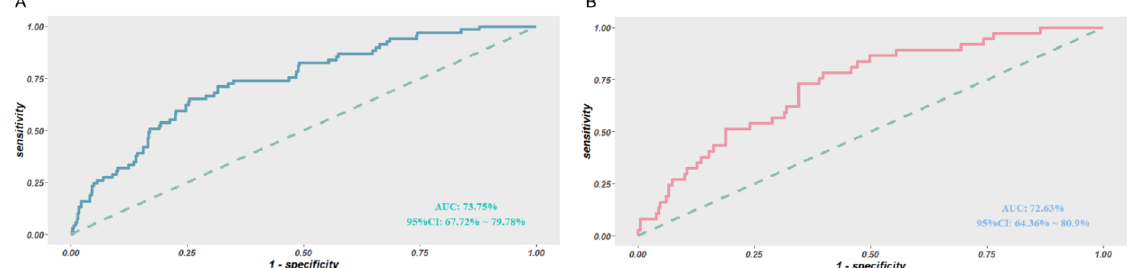
Figure 4. ROC curves of the MCI risk nomogram prediction in the training set ( A ) and in the validation set ( B ). The y-axis indicates the true-positive rate of the risk prediction. The x-axis indicates the false-positive rate of the risk prediction.